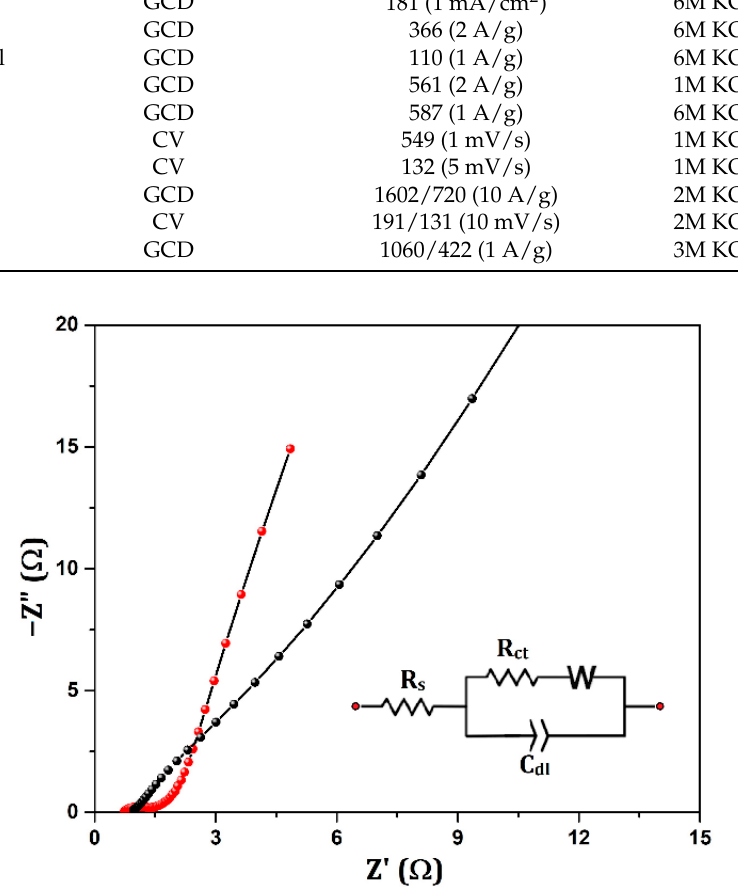
Figure 6. EIS plot of the NF (black) and NiO/Ni/NF(red) electrode at open circuit voltage (OCV) (the inset is the equivalent circuit representation).